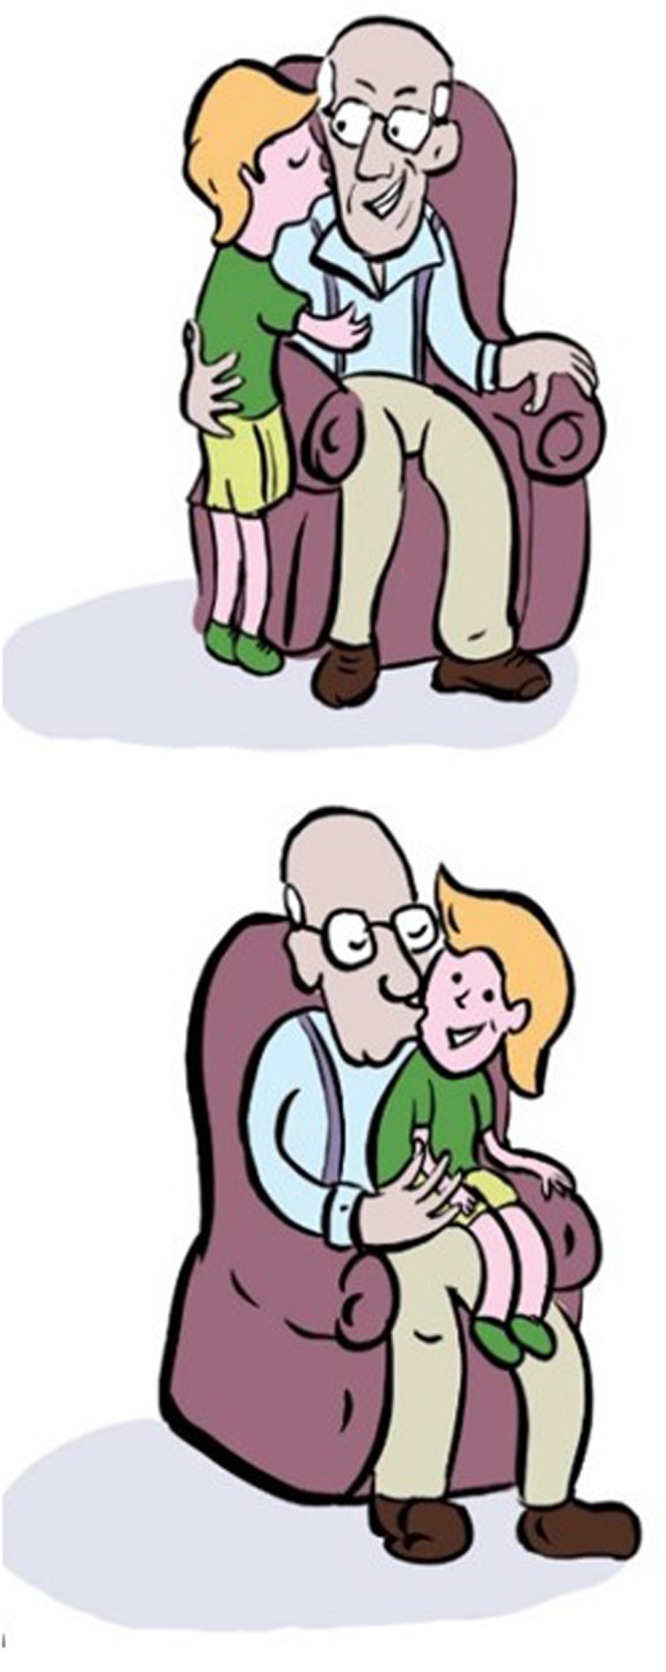
An example for a picture pair used in Experiment 1. Das ist der Junge der den Opa küsst That is theMASC,NOM boy whoMASC,NOM theMASC,ACC grandfather kissed. ‘That’s the boy who kissed the grandfather’